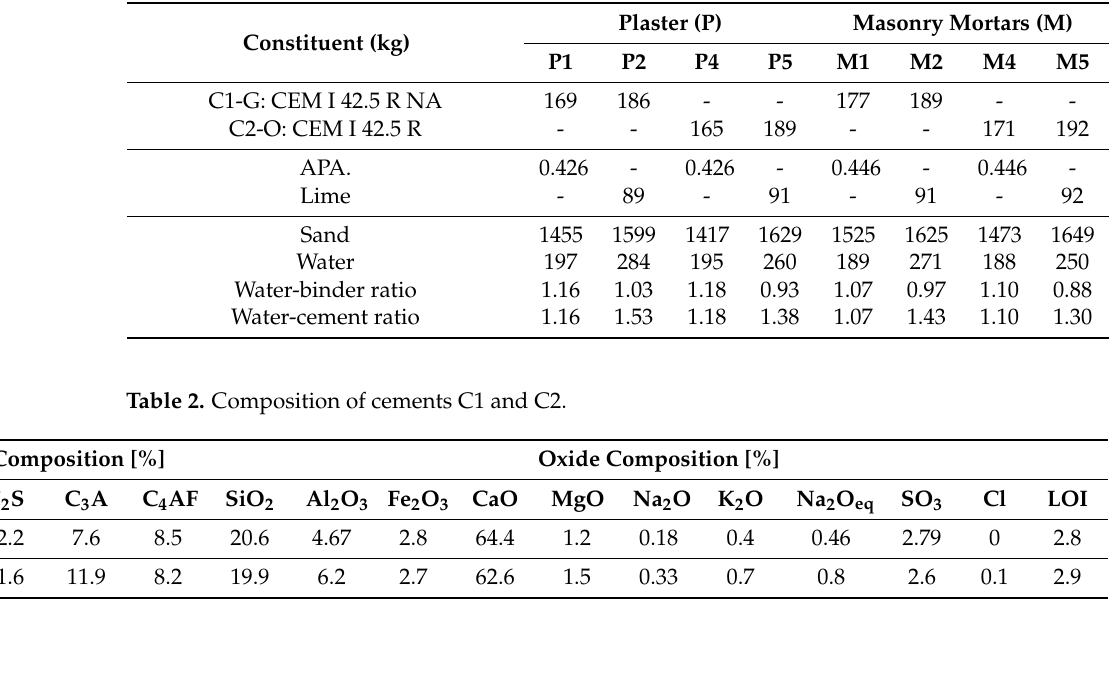
Table 1. Composition of plaster (P) and masonry mortars (M) (kg/m 3 ).